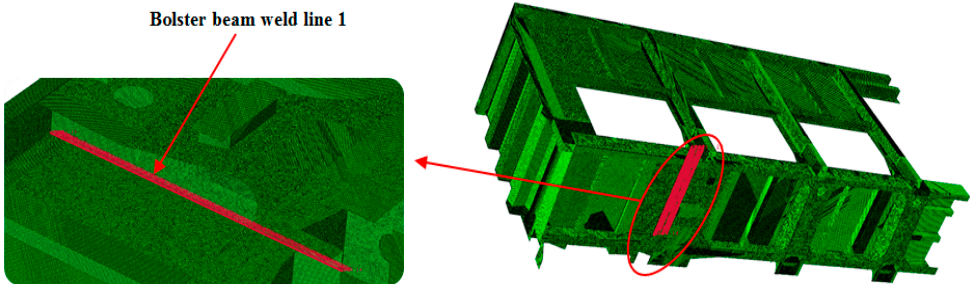
Figure 5. Finite element model of the gondola car body